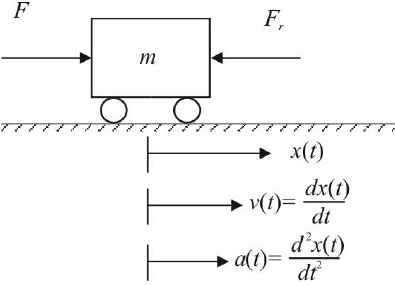
Figure 1. Description of an autonomous vehicle movement in one